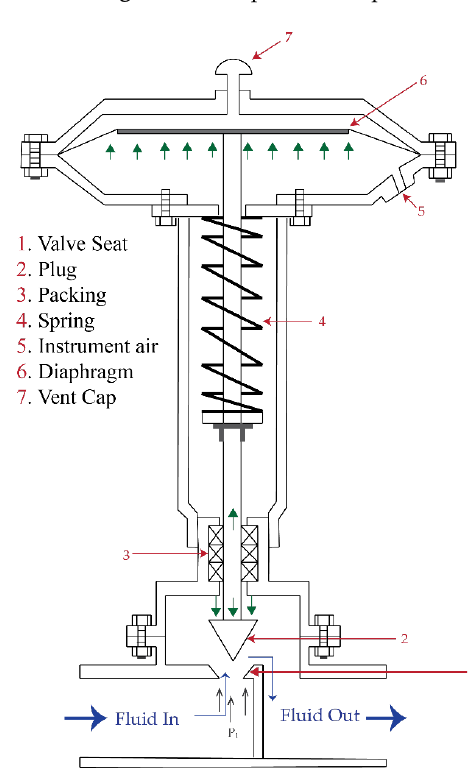
Figure 3. Cross-sectional diagram of a pneumatic control